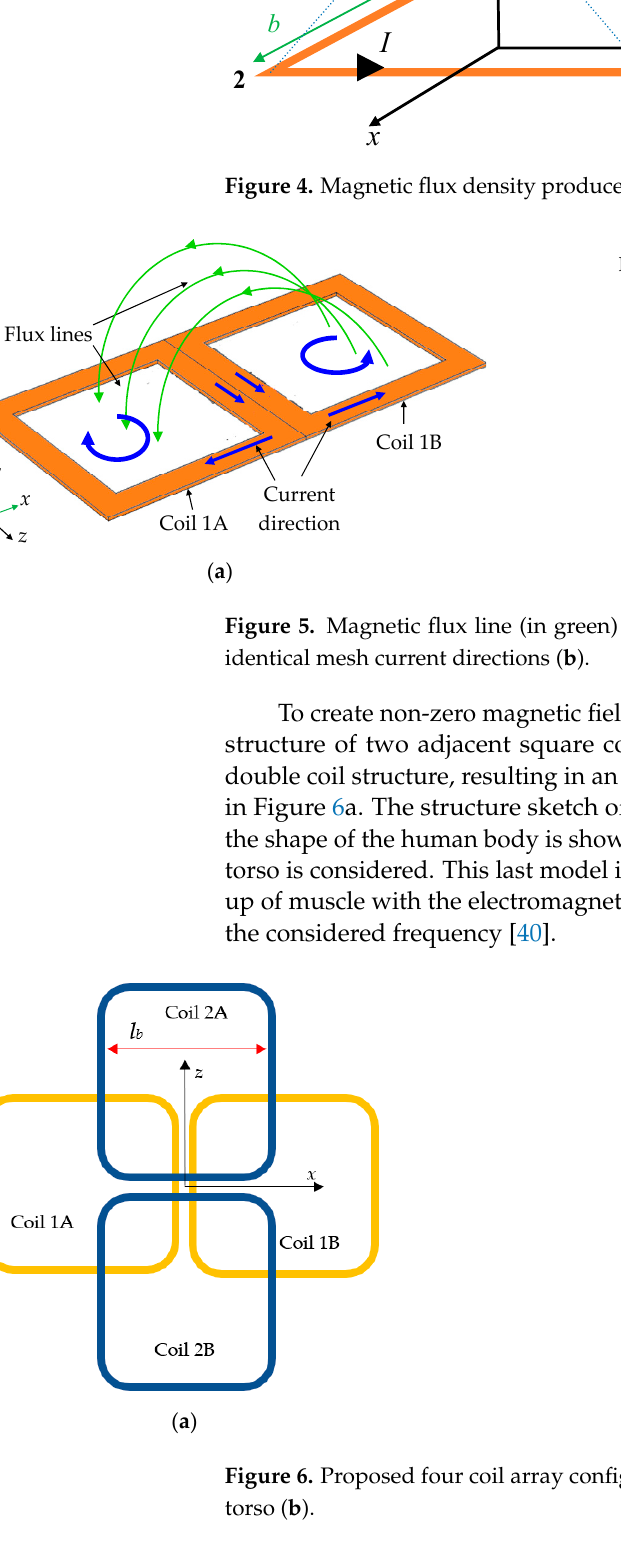
Figure 4. Magnetic flux density produced by a rectangular coil.